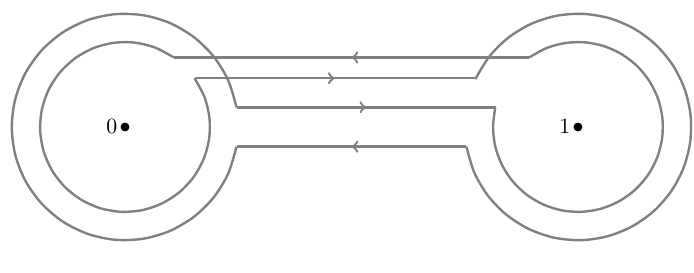
Figure 8 . Pochhammer